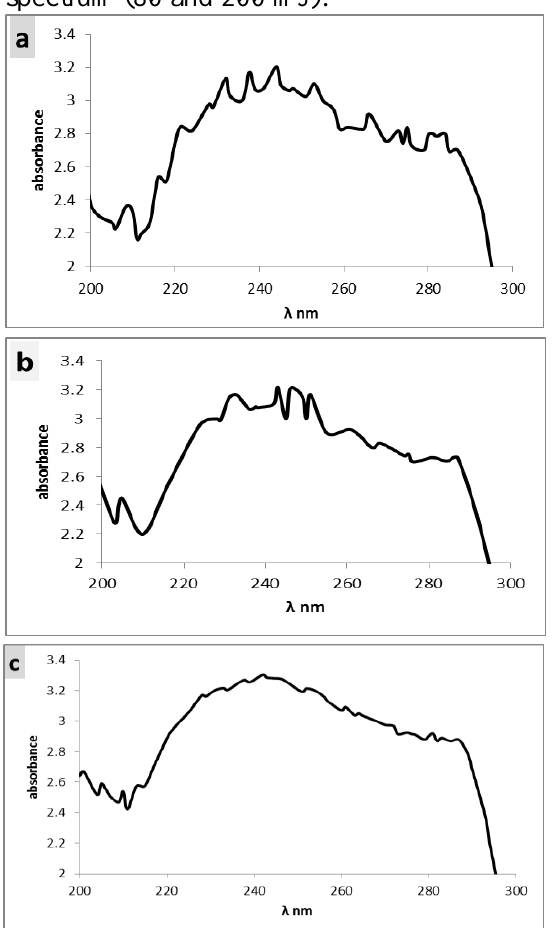
Fig.7: UV-Visible absorption spectrum of CNPs suspensions at different laser energy a) 20 mJ b) 80mJ C)